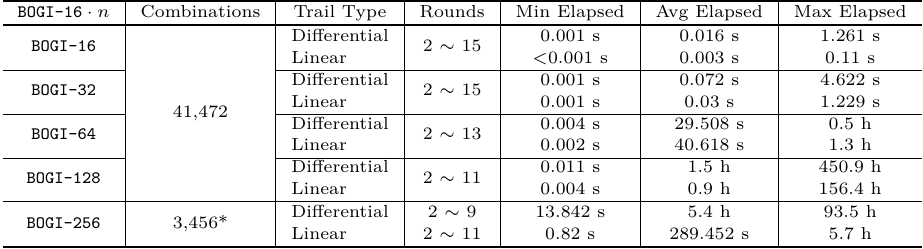
Table 6: Summary of the Best Trail Searches on BOGI-Based Ciphers BOGI-16 ·